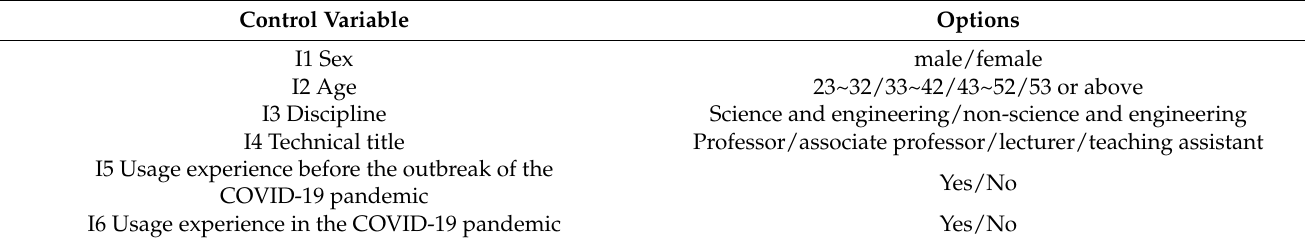
Table 9. Control variable and their